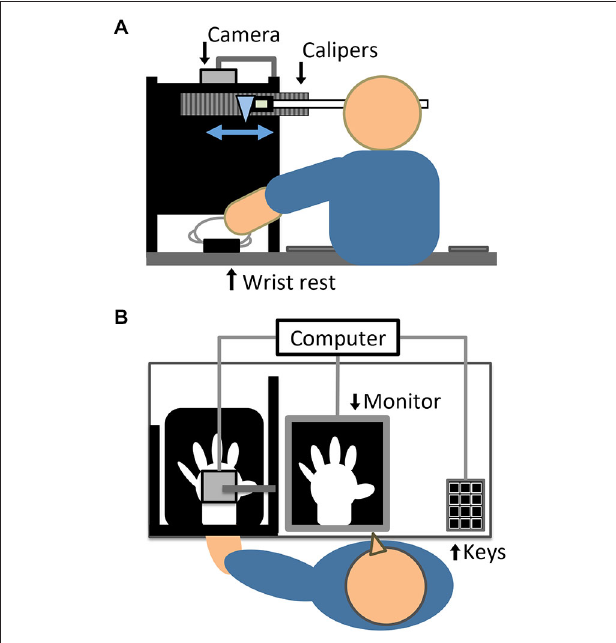
FIGURE 1 | Experimental setup, depicted in (A) elevated and (B) horizontal views . In the actual experiment, a black cloth covered the tabletop and participants wore a black cape covering the left arm and